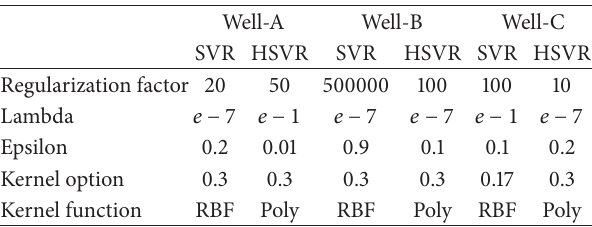
Table 3: Optimum parameters for each of the wells.